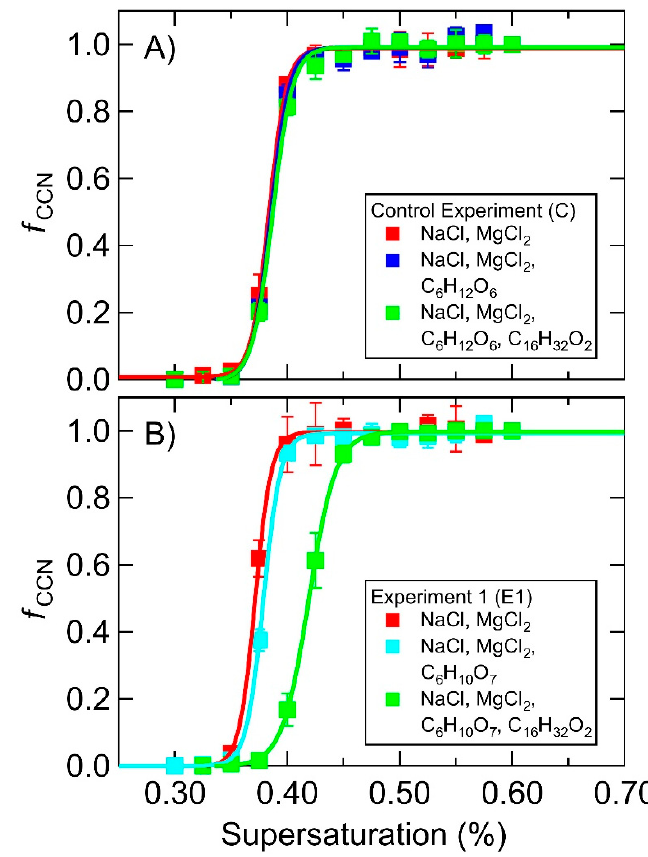
Figure 2. Representative CCN activation spectra for the control experiment (panel A) and experiment 1 (panel B) MART experiments consisting of a starting salt matrix (red), addition of 95 µ M glucose (dark blue, panel A) or glucuronic acid (light blue, panel B), and subsequent addition of 35 µ M palmitic acid (green).